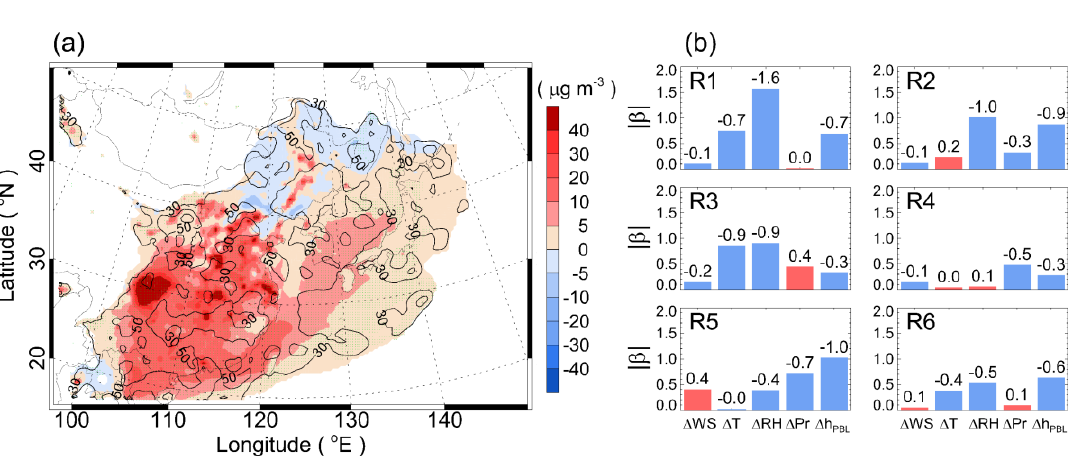
Figure 11. ( a ) Spatial distribution of the determinant coe ffi cients (R 2 ) from multiple linear regression analyses and ( b ) the regression coe ffi cients ( β i ) of meteorological factors at six subdivisions. The di ff erences in the PM 2.5 concentration and the meteorological variables were calculated by ∆ C = C ∆ M = M − C − M WRF-Chem WRF / CMAQ and WRF-Chem WRF / CMAQ , respectively. The meteorological variables are 10-m wind speed ( ∆ WS ), 2-m temperature ( ∆ T ), relative humidity ( ∆ RH ), precipitation ( ∆ Pr ), and PBL height ( ∆ h PBL